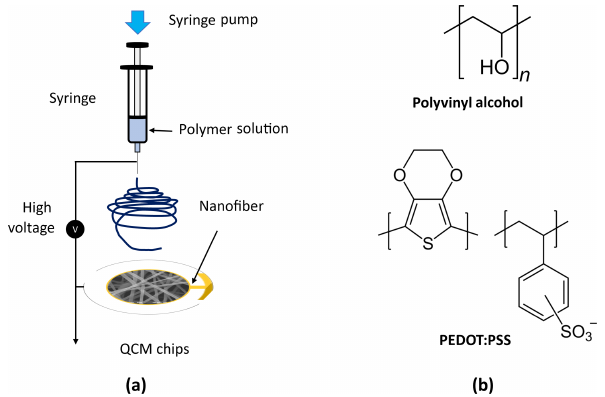
Figure 1. (a) Electrospinning setup and (b) chemical structure of PVA and PEDOT–PSS.